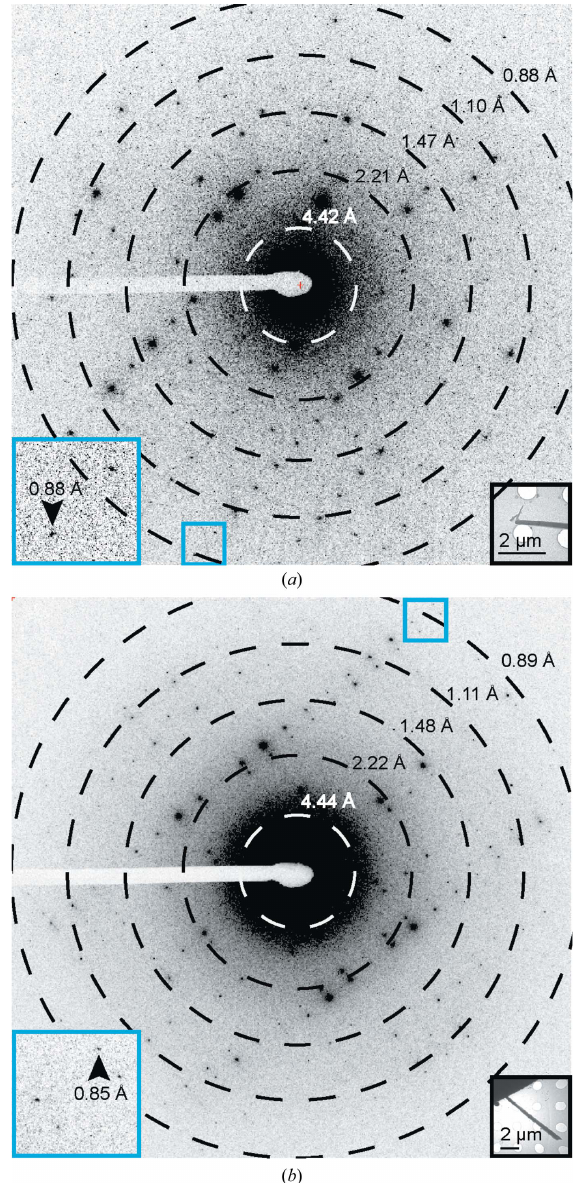
Figure 1 Single diffraction patterns of homochiral l -GSTSTA ( a ) and racemic GSTSTA ( b ) measured during continuous-rotation MicroED data collection. Each pattern corresponds to a 0.6 (cid:4) wedge ( a ) or a 0.9 (cid:4) wedge ( b ) of reciprocal space. Black insets show overfocused diffraction images of the crystals used for diffraction; blue squares correspond to magnified regions (blue insets) of the pattern that show diffraction at sub-0.9 A˚ resolution (black arrows). Resolution circles are indicated by rings; scale bars are 2 m m in